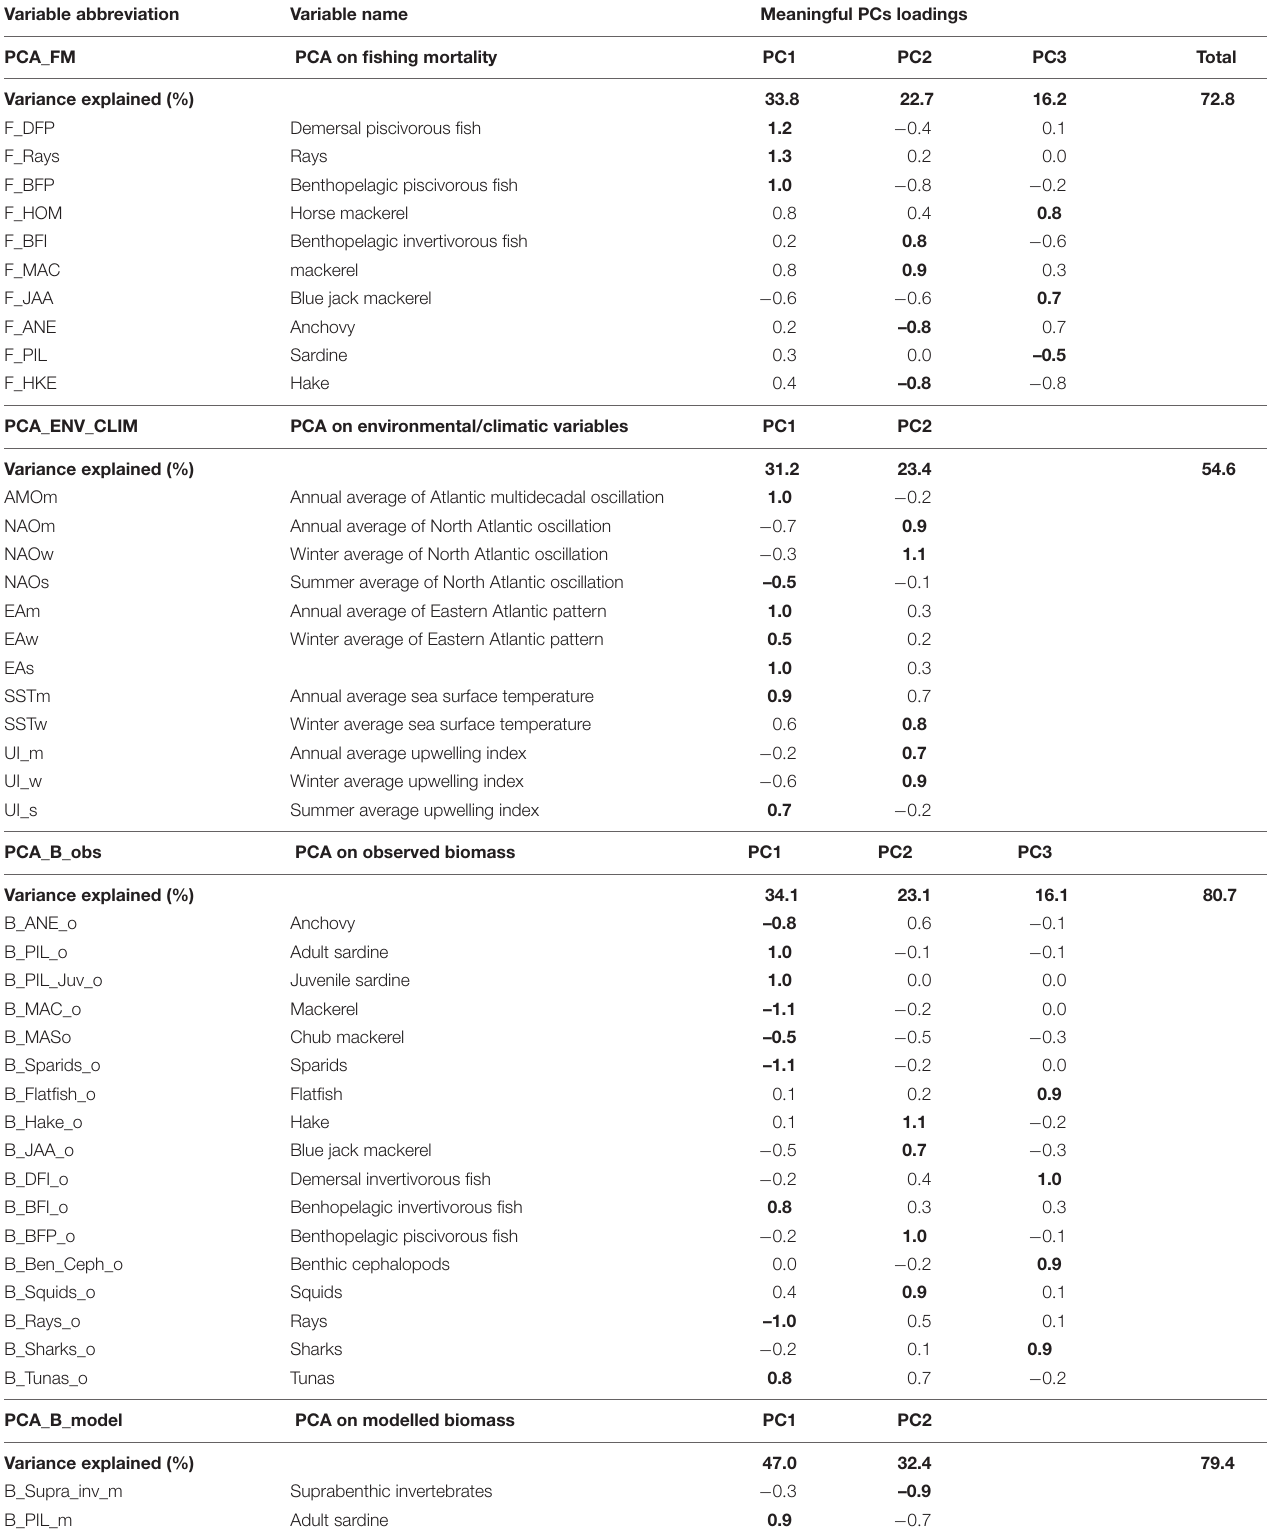
TABLE 4 | Contribution of each variable to meaningful principal components for each PCA performed. Variable